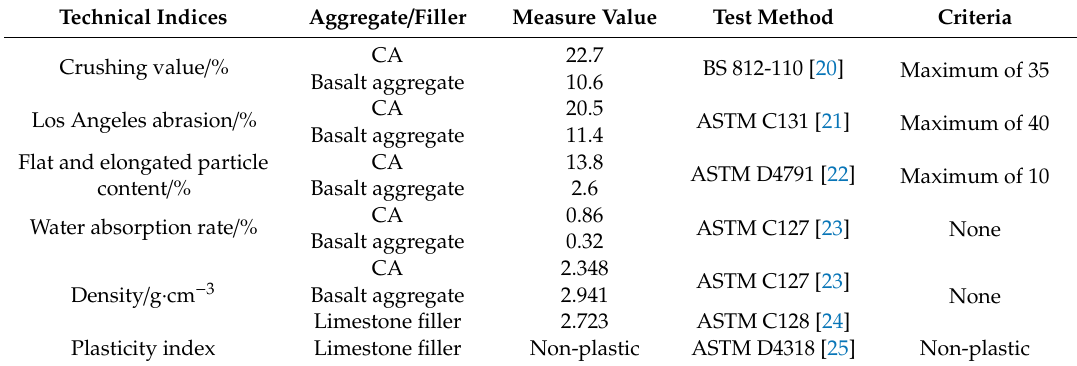
Table 1. Physical properties of aggregate and filler used in this study.